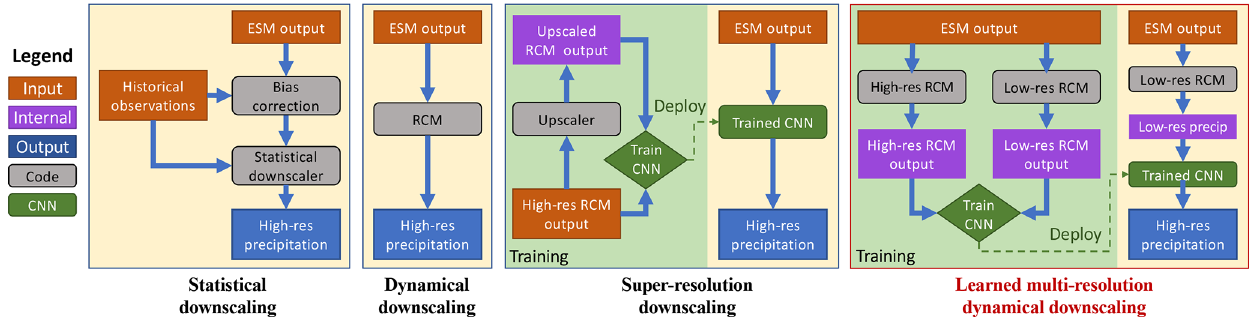
Figure 1. Four downscaling approaches discussed in the text. Orange and blue rectangles are input and output, respectively, of each down- scaling approach, and grey rounded rectangles are computational steps. In our learned multiresolution dynamical downscaling approach (right), we use the outputs from low- and high-resolution dynamical downscaling runs driven by the same ESM as boundary conditions to generate { Low, High } training data pairs for a CNN that, once trained, will map from low-resolution dynamically downscaled outputs to a high